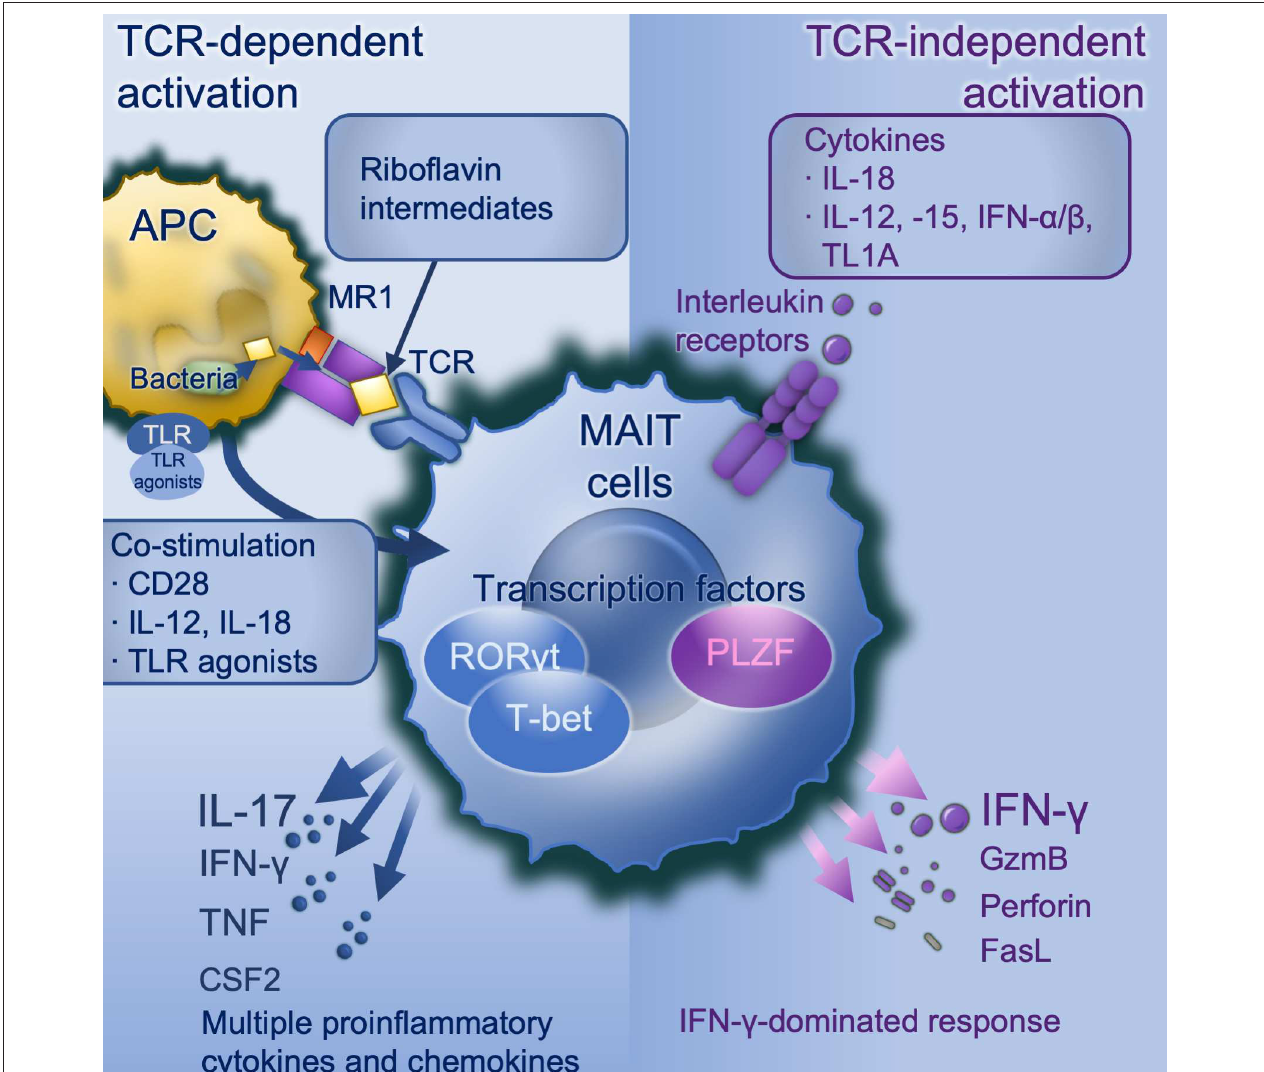
FIGURE 1 | MAIT cell activation. TCR-dependent activation requires microbially-derived riboflavin intermediates such as 5-OP-RU to be presented on MR1 to a MAIT cell TCR in conjunction with co-stimulation. Co-stimulation may include CD28 and/or cytokines particularly IL-12/-18, and can be induced by danger signals including TLR agonists (in mice TLRs 3, 4, 6/2, or 9, in human TLRs 1, 2, or 6). TCR dependent activation induces a strong and broad production of pro-inflammatory cytokines and chemokines, dominated by IL-17A under the control of the transcription factor ROR γ t. TCR-independent activation is driven by IL-18 in synergy with IL-12, or − 15, or IFN- α or - β , and potentiated by TL1A. This activates a more modest cytokine response dominated by IFN- γ under the control of PLZF. APC, antigen-presenting cell; CD, cluster of differentiation; CSF2, colony stimulating factor 2 (GM-CSF); GzmB, granzyme B; IFN, interferon; IL, interleukin; MAIT, mucosal associated invariant T; MR1, major histocompatibility complex-related protein-1; PLZF, Promyelocytic leukaemia zinc finger protein; ROR γ t, retinoic acid-related orphan receptor gamma; TCR, T cell receptor; TL1A, tumor necrosis factor (TNF)-like protein 1A (TNFSF15); TLR, toll-like